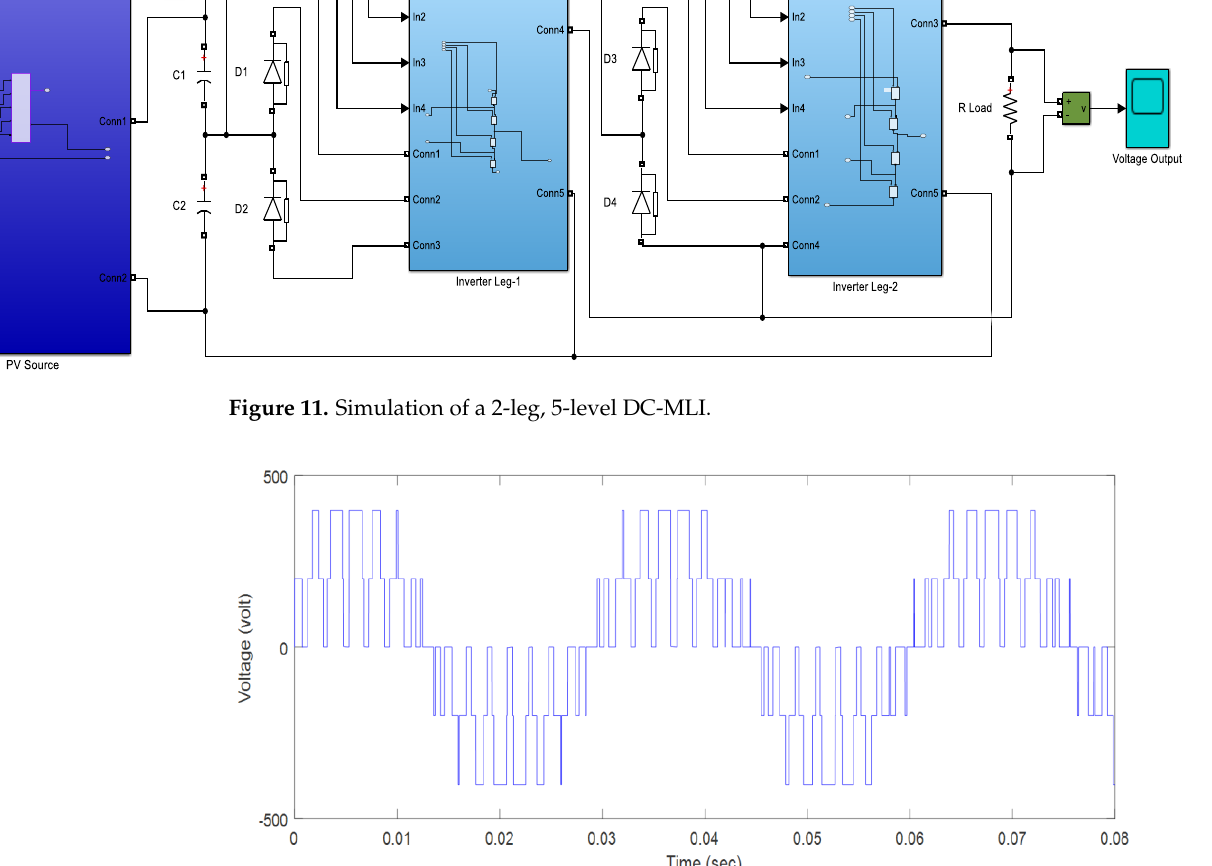
Figure 12. Five-level DC-MLI output voltage waveform.